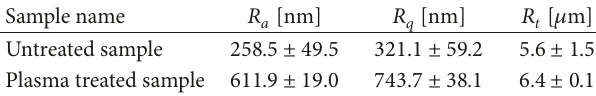
Table 1: Roughness parameters for the tested surfaces.